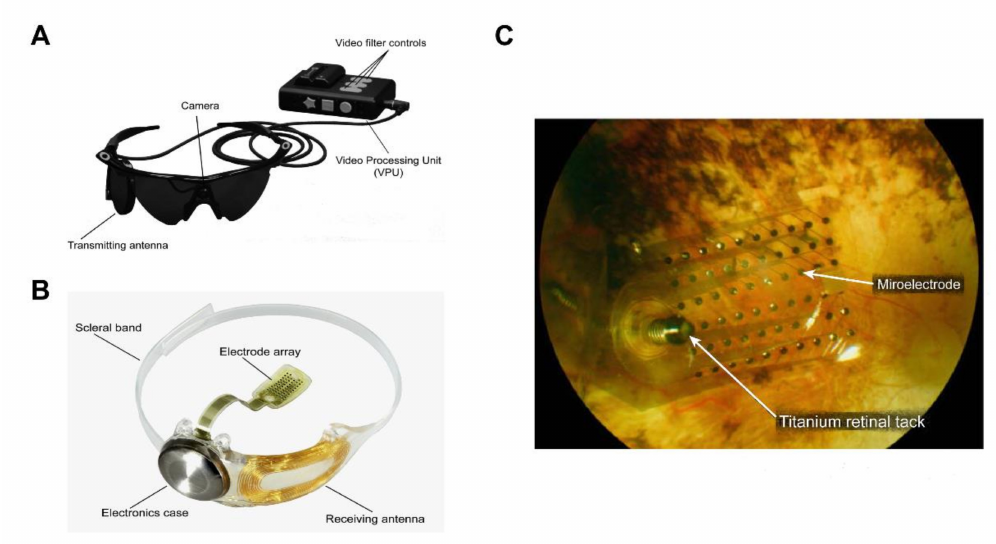
Figure 3. The Argus ® II retinal prosthesis system consists of implanted and external components. ( A ) The external components include glasses, a video processing unit (VPU), and a cable that